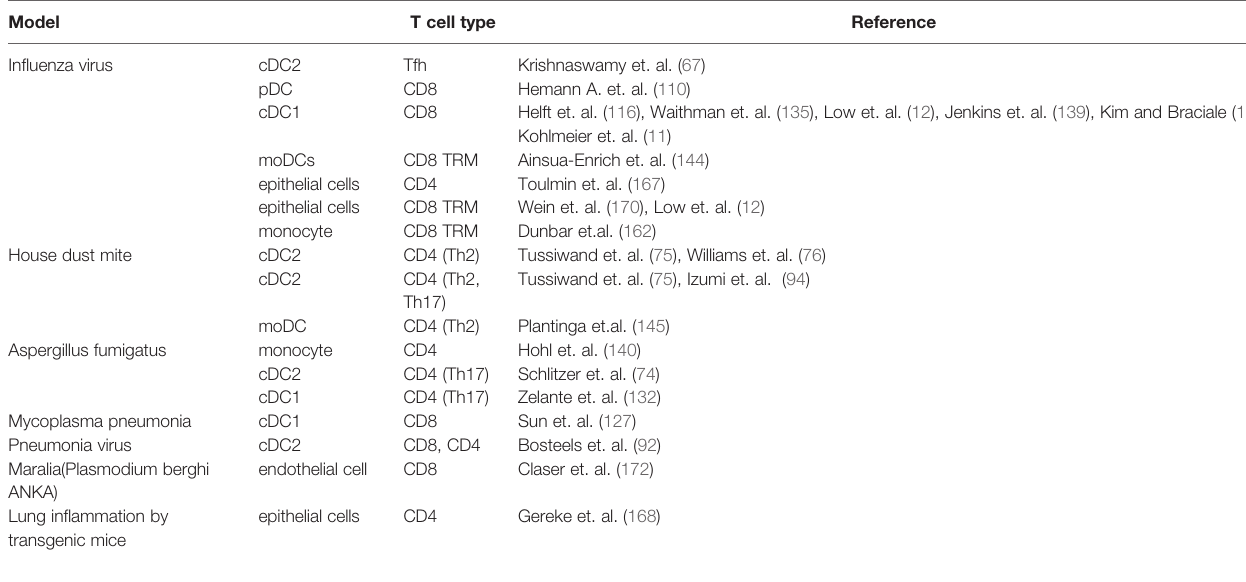
TABLE 1 | Lung APCs and their roles in T cell